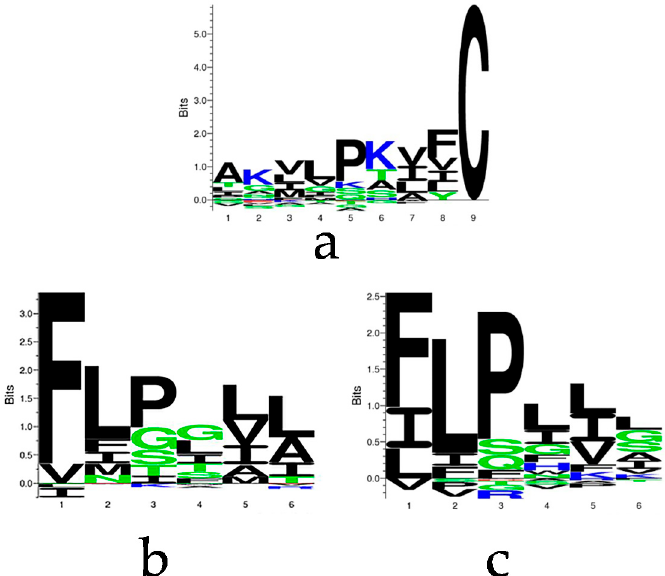
Figure 1. Motif analysis of the selected sequences from Antimicrobial Peptide Database (APD3). The sequence cluster of ( a ) 9 amino acid residues before the rana box domain of 121 brevinin-1 peptides, ( b ) the N-terminal 6-mer peptide of selected brevinin-1 peptides, and ( c ) the N-terminal 6-mer peptide of 102 temporin peptides. The hydrophobic and positively charged amino acids are coloured by black and blue, respectively. Table 1. The physicochemical properties of Brevinin-1 peptides and B1A’s analogues. Peptide Sequences